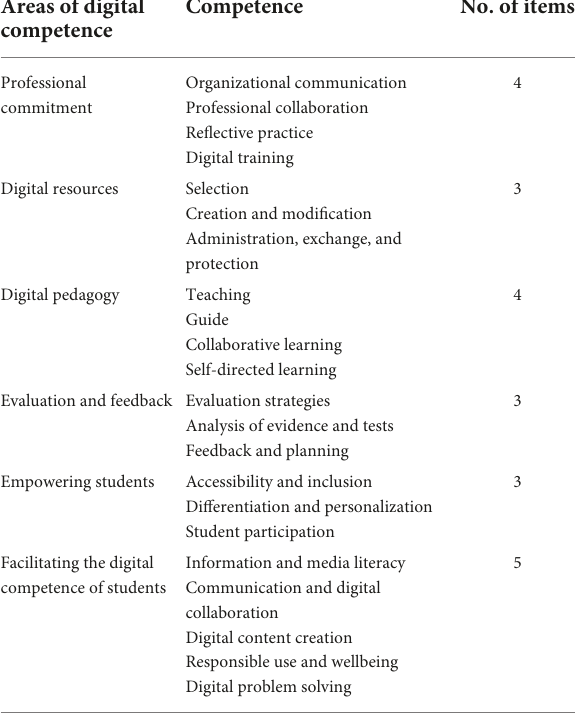
TABLE 2 Structure of the “DigCompEdu Check-in” instrument. Areas of digital Competence No. of items competence